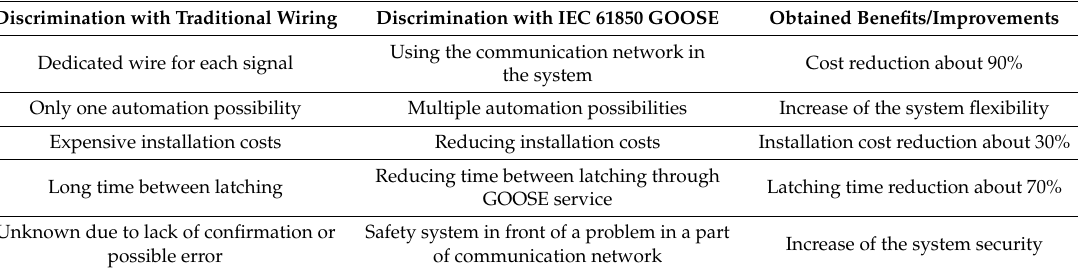
Table 3. Comparative analysis between IEC 61850 and traditional